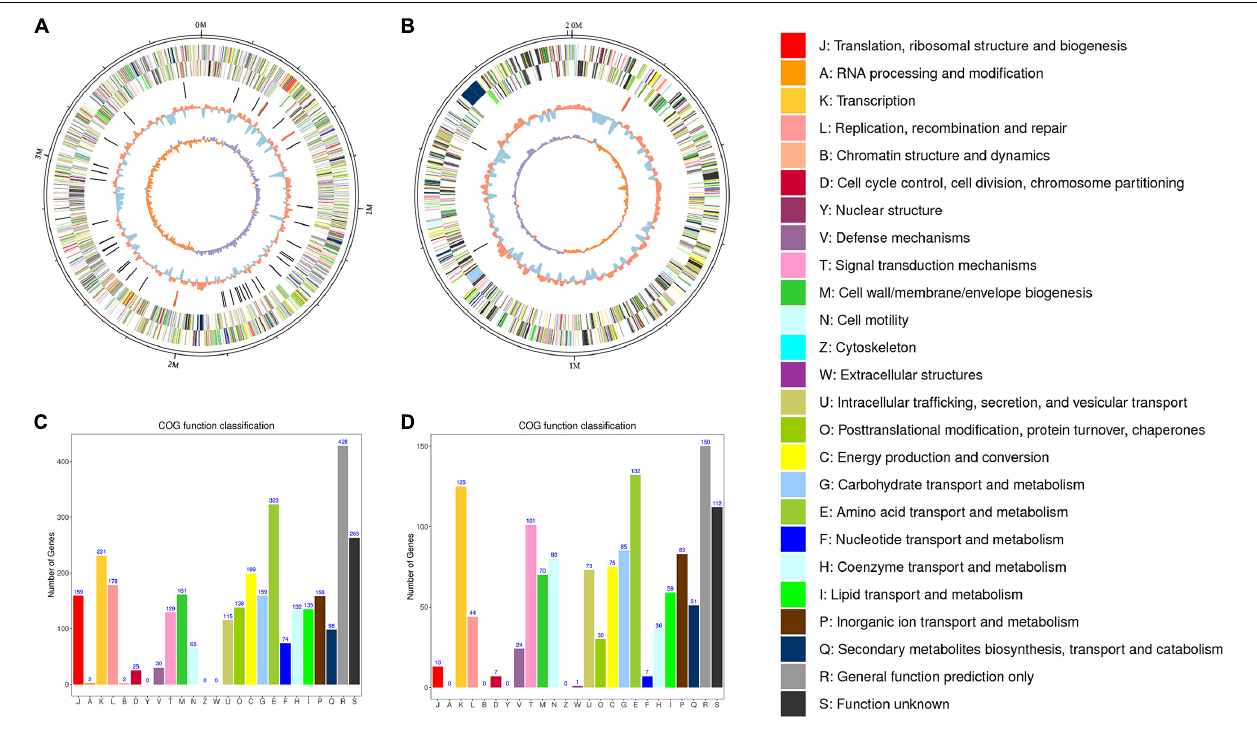
FIGURE 2 | Circos plot of the genome of R. solanacearum strain PeaFJ1. The genome of strain PeaFJ1 consists of a chromosome contig with a full length of 3,800,378 bp (A) and a megaplasmid contig with a full length of 2,008,534 bp (B) . From the outer circle to the inner circle, it represents the length of chromosomes, CDS, tRNAs, GC content, and GC skew curve, respectively. (C,D) The distribution of genes with COG functional categories in the chromosome (C) and the megaplasmid (D) of PeaFJ1. Different colors represent different COG functional classifications that were explained in the right side.